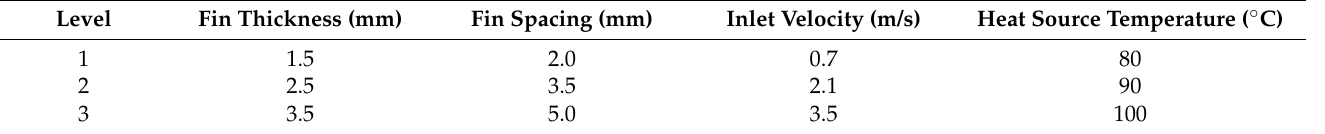
Table 2. Levels and factors for DOE matrix for fins heat sinks.